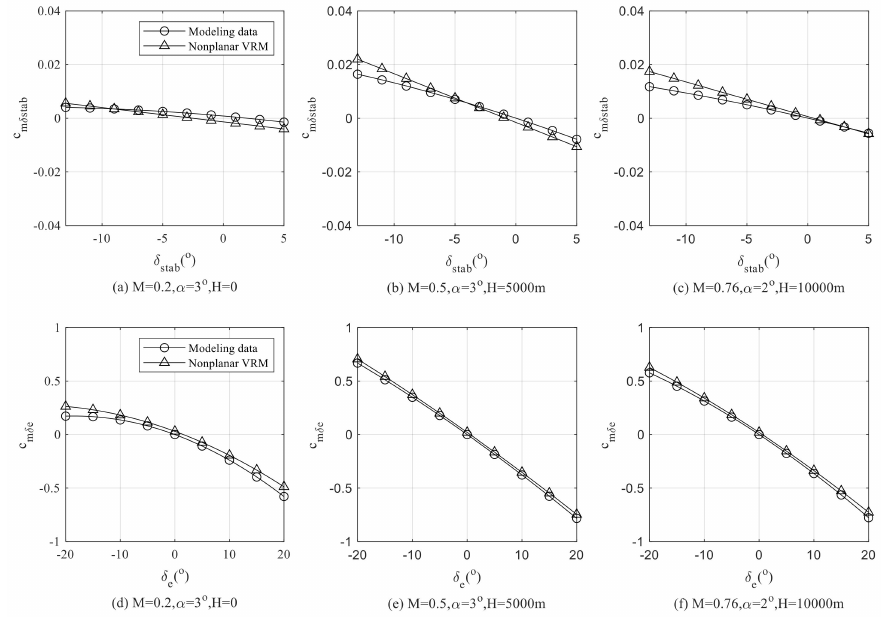
Figure 10. Comparison of computation and experimental pitching moment coe ffi